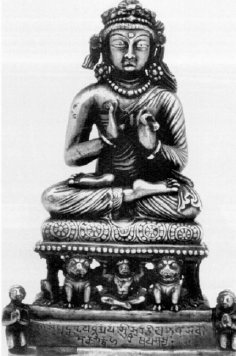
Figure 10. Buddha wearing a crown performing the dharmacakra-pravartana mudra . Commissioned by Ś r ī Surabh ī and the monk Hari ṣ aya ś a, 678/679 C.E. Gilgit. Brass with copper and silver inlay. 22cm H. Tibet Museum, Alain Bordier Foundation, Gruyeres/Suisse (No. 3). (item #3 on website page)